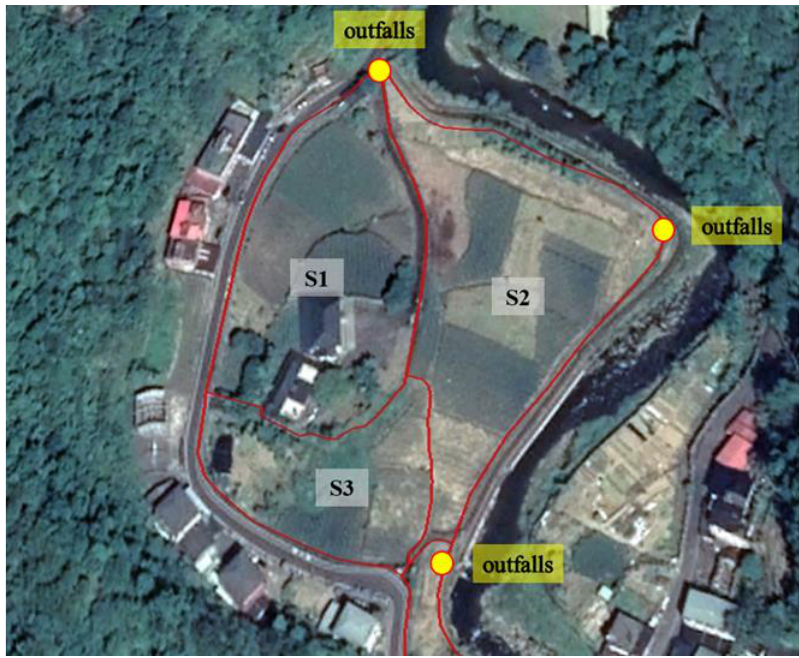
Figure 7. Example tea farm within the Jinggualiao watershed. This tea farm has three subwatersheds and 3 outfalls. Table 5. Determination process for the S1 subwatershed in the case tea farm.